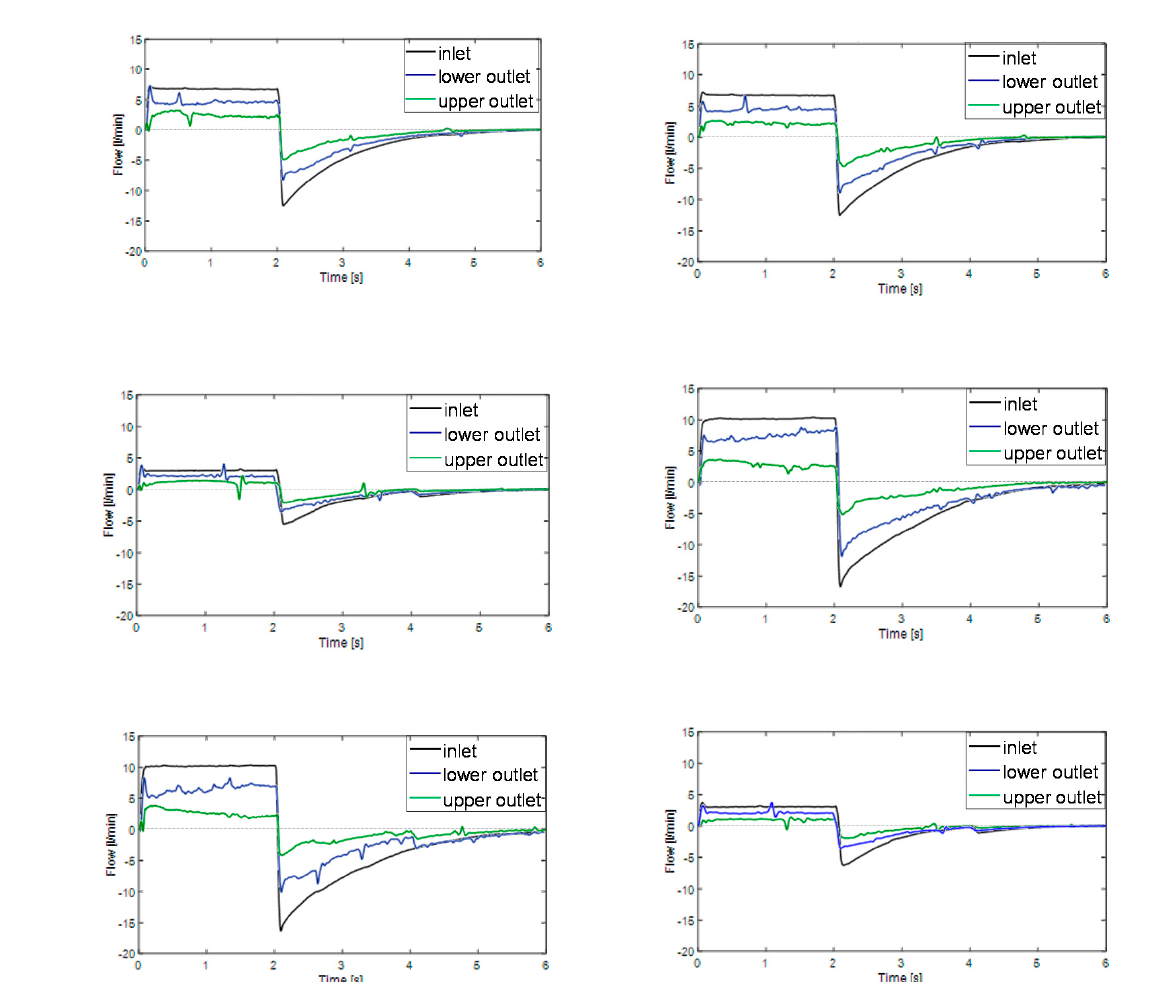
Figure 5. Flow-time relationships during breath cycle for model lungs with normal compliance (ca. 100 mL/cm H 2 O) for various tidal volume divisions (lower outlet—branch with higher compliance; upper outlet—branch with lower compliance). Time 0–2 s represents inspiration phase, time 2–6 s represents expiration phase.